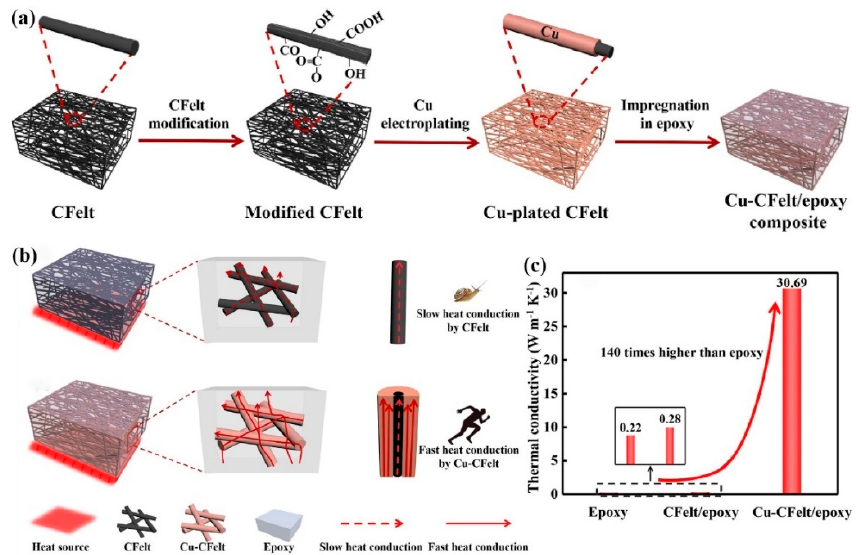
Figure 19. ( a ) Schematic of fabrication process of the Cu-Carbon felt (CFelt)/epoxy composites. ( b ) Schematic illustration of the heat conduction in the CFelt/epoxy and Cu-CFelt/epoxy composites. ( c ) λ of Cu-CFelt/epoxy (reproduced with permission from [58]).